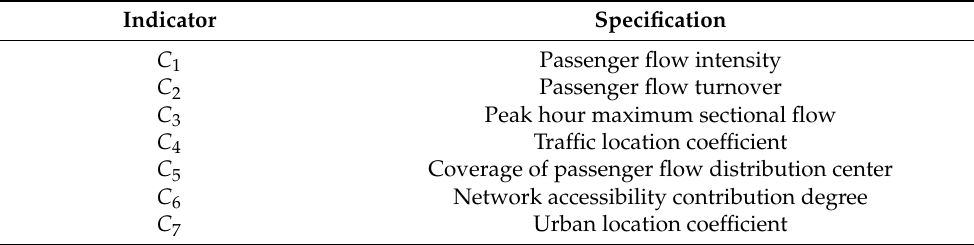
Table 5. Decision indicators for Chengdu (extracted from the Chengdu rail transit network planning report (2016–2050)).